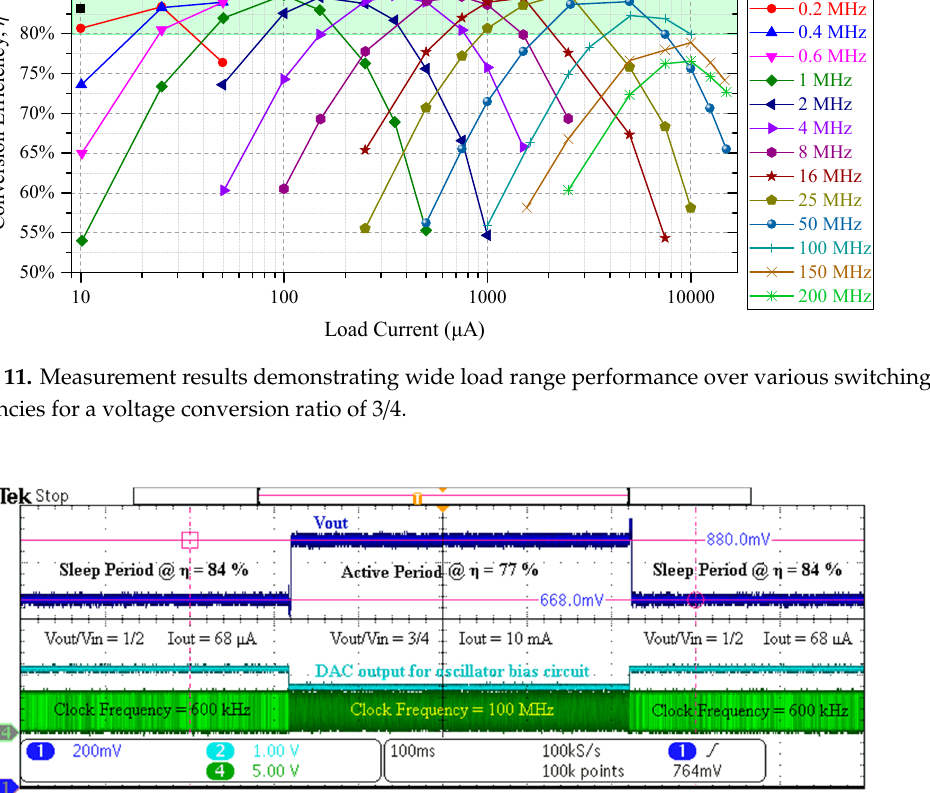
Figure 12. Measurement result for transitions between sleep and the active period of the load.